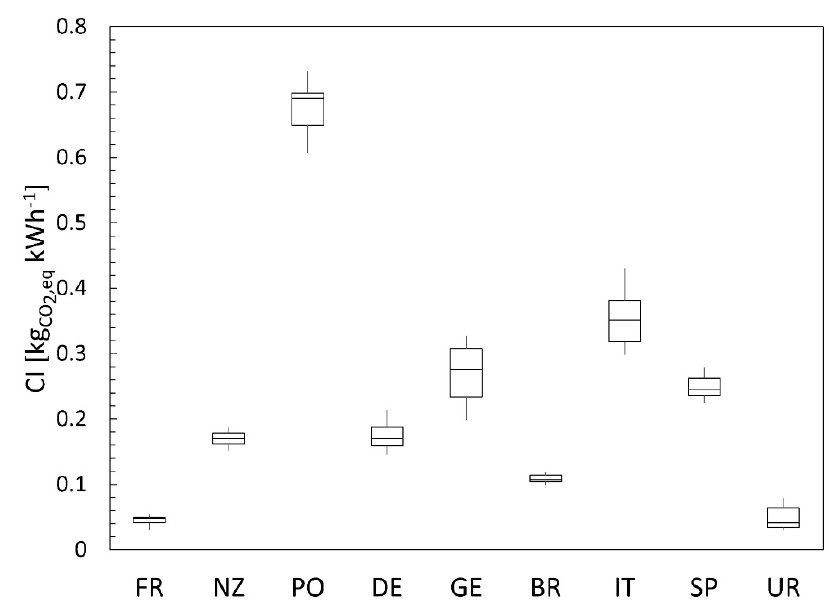
Figure 3. Box-plots of carbon intensities for different countries (based on data from Tomorrow [45]).